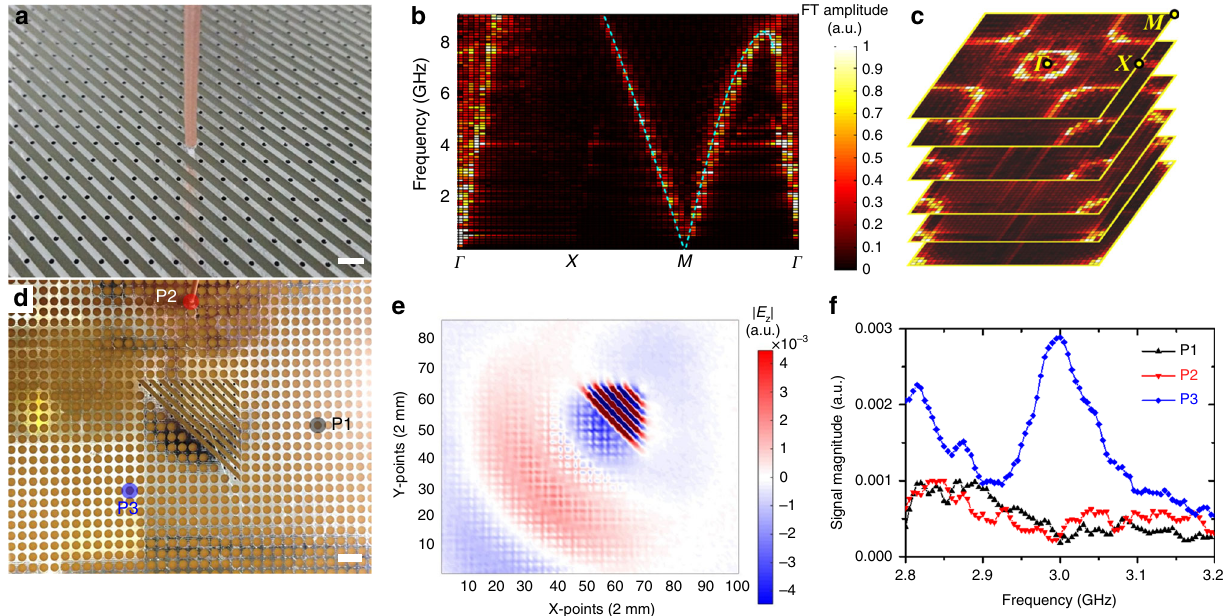
Fig. 6 Experimental results at microwave frequencies. a A square sample of the metasurface with 40 × 40 periods. Scale bar, 5 mm. A source antenna was placed below the PCB board to excite the guided mode and the E z fi eld was measured by scanning a monopole antenna on top of the PCB board. b Fourier spectrum of the measured E z fi eld along high symmetry k -lines. A light cone at the M point was observed, in good agreement with the calculated dispersion (cyan dashed line). c Fourier spectra for different frequencies, 0.95, 1.96, 3.08, 4.42, 5.89, and 7.07 GHz (from bottom to top). The equifrequency contours form rings near the M points with increasing radii as frequency increases. d A top view of another sample demonstrating the orientation-dependent coupling effect, where three speci fi c positions are labeled with color symbols (black, red and blue) and the probing antenna is located on one of them. Scale bar, 1 cm. e The distribution of the real part of E z at frequency 2.99 GHz. f The signals received at three positions, as denoted by the color labels (black for P1, red for P2, and blue for P3) in